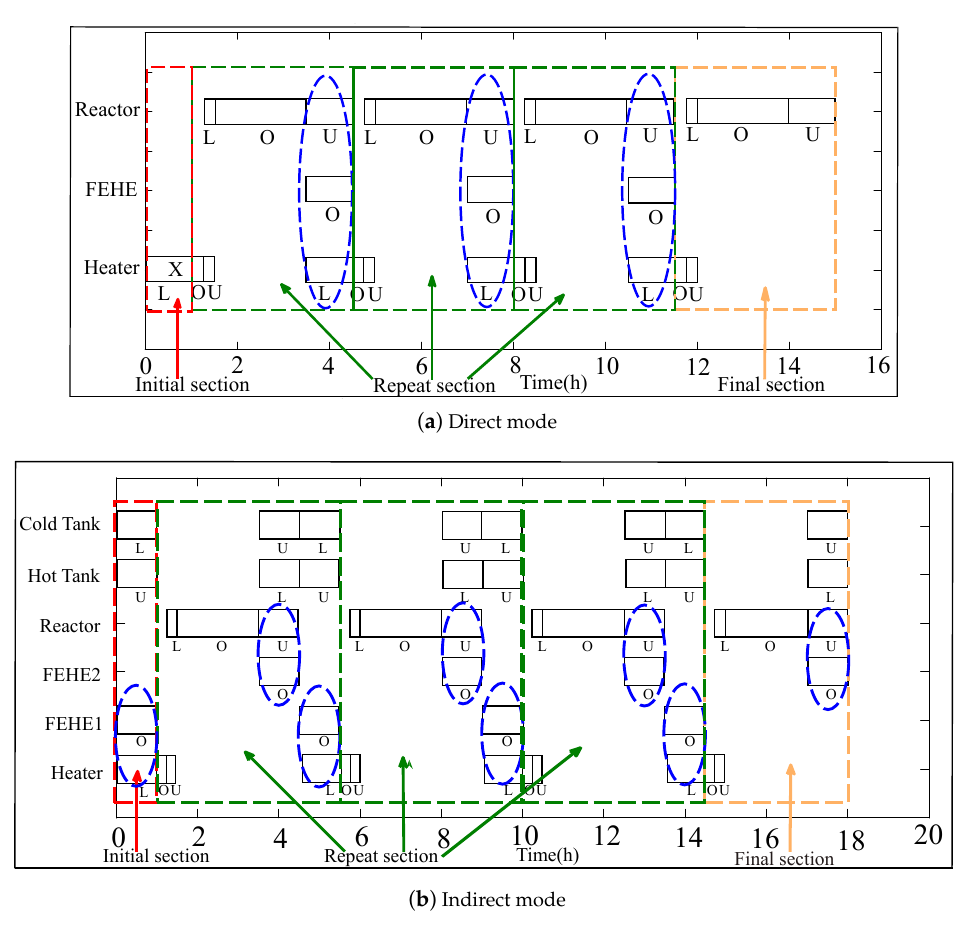
Figure 2. Optimal schedules for the BR-FEHE system (L, loading phase; U, unloading phase; O, operating phase; X, stand-alone